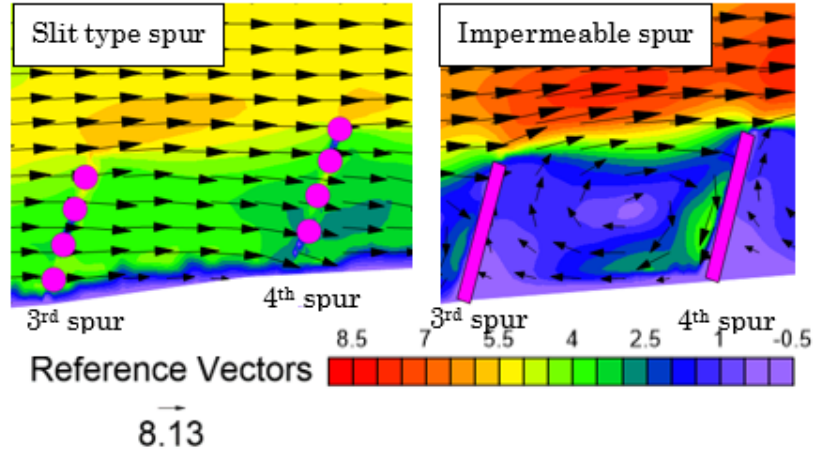
Figure 16. The distribution of the spatial velocity ( u , v ) in m / s inside the third embayment. The contours show the magnitude of the spatial velocity ( = (cid:3495)(cid:3435)𝑢 (cid:2870) + 𝑣 (cid:2870) (cid:3439) in m/s. The distribution of the transverse velocity ( 𝑣, 𝑤 ) after the third spur is shown in Figure 17. Without any spur (case 1), the transverse velocity (𝑣) varies from − 0.52 m/s to 1.06 m/s. Near the bank, a high bank-directed velocity was observed (0.86 m/s). By placing slit-type or impermeable spurs, the transverse velocity can be lowered. In the slit-type spur case, at the same location, the transverse velocity component, 𝑣 , becomes 0.61 m/s, and in the impermeable spur case, it becomes − 1.71 m/s. Such a strong recirculating velocity was also observed [4] in the real field. Researchers [62] also concluded that in the dead zones of impermeable spur-like structures, the main transport mechanism is transverse turbulent diffusion which controls the exchange processes with the mainstream. Therefore, this type of recirculating velocity can initiate or increase local scouring. Just after crossing the spur dike region, a high peak in the transversal velocity was observed in both cases, which resembled a DSL. Figure 18 shows the vortical structure of the mean flow using the Q criterion. This figure also indicates a 50% to 70% higher velocity in the DSL layer in the impermeable case than in other cases, especially at the tip of the first spur. The exchange coefficient between the third embayment and the main channel was calculated using the methods described in a previous study [63]. Figure 19 shows the distribution of the exchange coefficient e, inside the third embayment of impermeable and slit type spur with respect to flow depth. The average exchange coefficient, e, in this zone was 0.2 in case of impermeable spur, while it was 0.08 in case of slit type one, indicates weaker turbulence coherent structure in silt type spur. By performing large eddy simulation (LES) in case of river bank lateral cavities, it was concluded [64] that in transverse direction, pressure gradient contributes largely to flushing momentum out of the cavities (embayment in this case) while Reynolds normal stress and convection are responsible for its entraining into the cavity. Figure 20 shows a similar agreement of the higher-pressure gradient in case of slit type spur. The distribution of bed shear stresses considering different conditions is shown in Figure 21. This figure indicates that in the no spur case, near the right bank, a high bed shear stress (8.2 to 14 N/m 2 ) occurred, and due to the installation of the spur dike, this stress decreased. In the case of slit- type spurs, the shear stress varies from 1.45 N/m 2 to 4.15 N/m 2 . Moreover, in the case of the impermeable spurs, the near-bank shear stress varies between 0.05 and 1.45 N/m 2 , but in this case, the opposite bank experiences a higher (22%) bed shear stress compared to that for slit-type spurs. As the considered river is braided in nature, this increased bed shear stress may expedite the development of the channel. Another observation is that, due to the channel bathymetry in the impermeable spur case, the main deflected flow impacts the bank further downstream (at approximately X = 2500 m). However, in the case of the slit-type spur, the modified field prevents such a bank-directed flow. In a real field, such a phenomenon was also observed. Figure 22 shows such an example in the study river (at Dhunot, Bogra, Bangladesh). Two impermeable spurs were